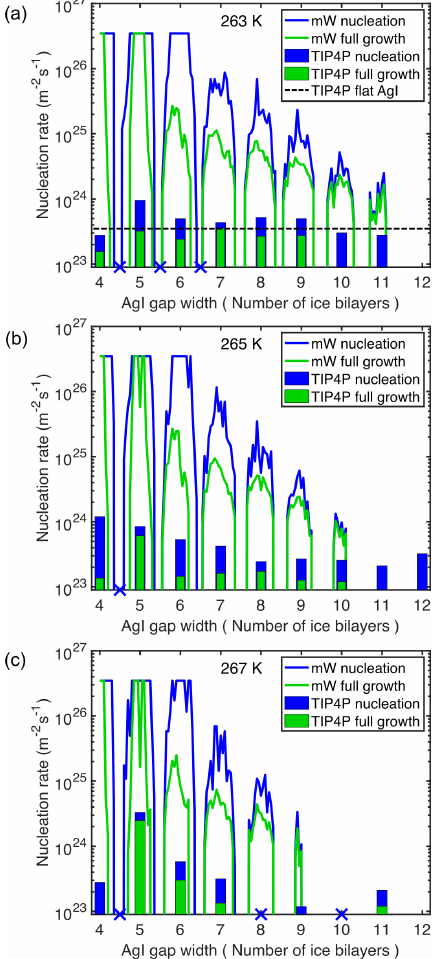
Figure 3. Nucleation rates in AgI slit simulations and inverse of time at which full ice growth in the AgI slit is observed, at (a) 263, (b) 265 and (c) 267K, with the mW model (continuous line) and TIP4P/Ice model (bar plot). Blue crosses indicate TIP4P/Ice simu- lations in which nucleation was not observed. The nucleation rate at 263K on the flat AgI(0001) surface using the TIP4P/Ice model is indicated by the dashed black line in panel (a) .